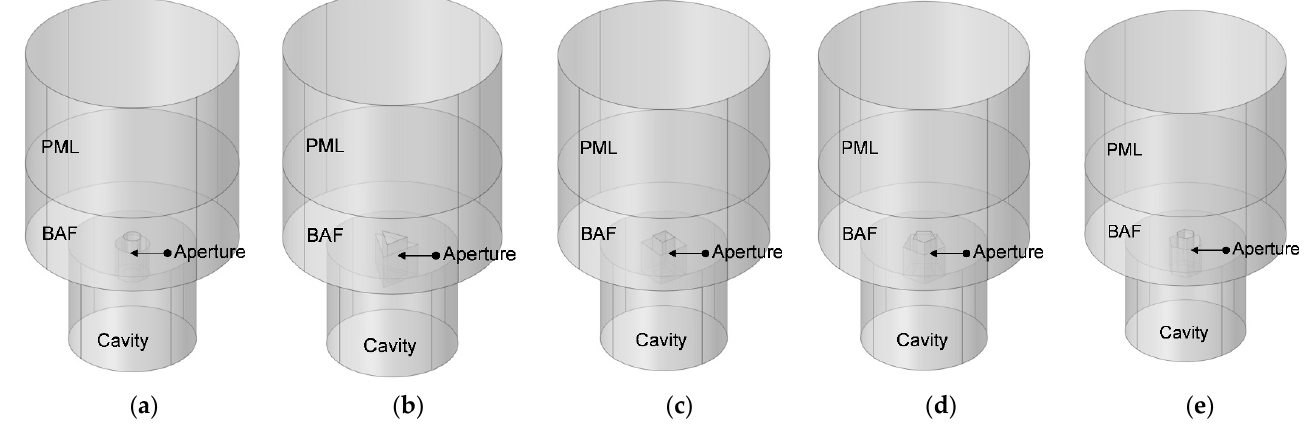
Figure 7. The three-dimensional finite element model for HRs with aperture for various cross-sec- tional shapes. ( a ) Round; ( b ) regular triangle; ( c ) square; ( d ) regular pentagon; and ( e ) regular hex- agon.